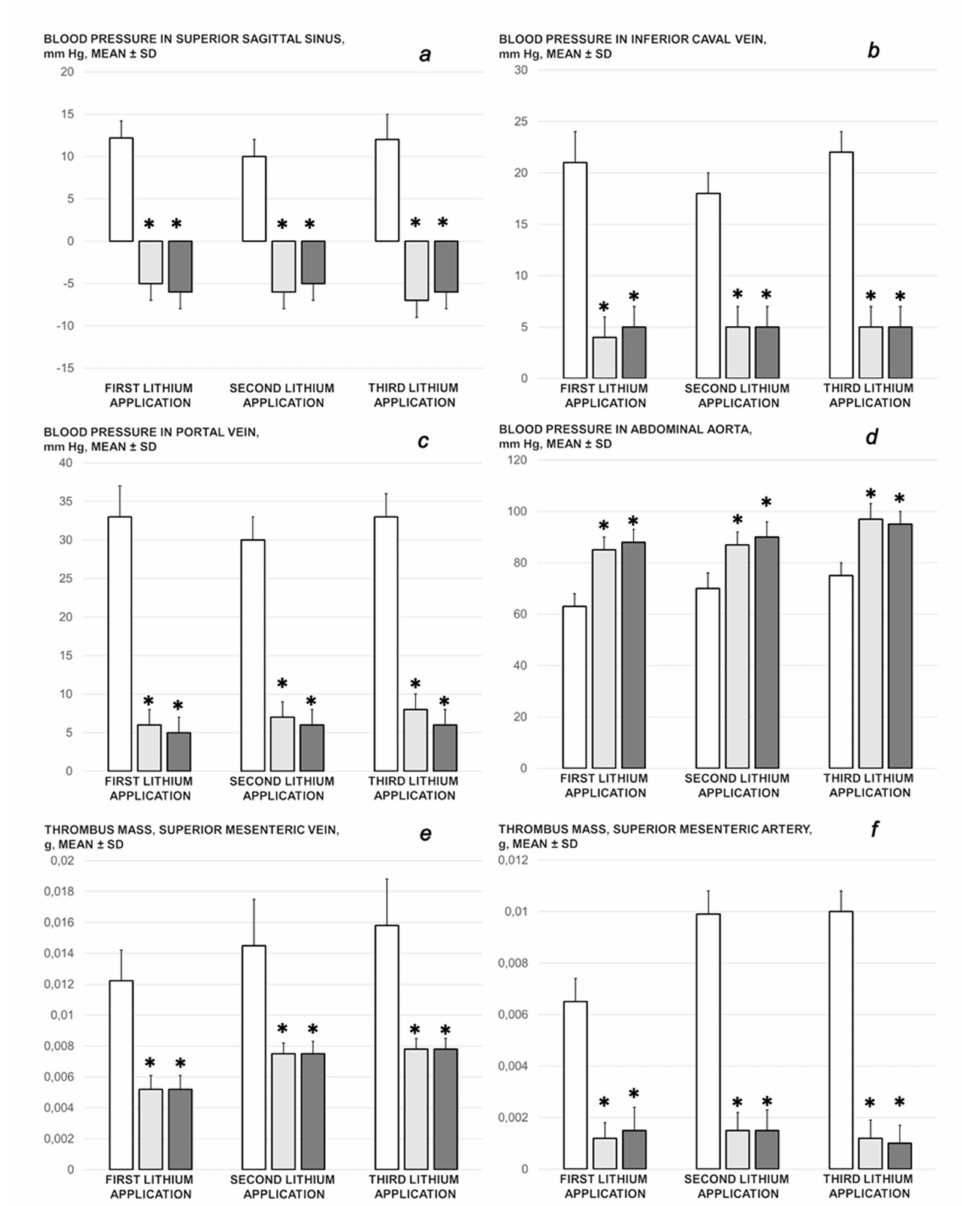
Figure 1. Blood pressure in the superior sagittal sinus ( a ), inferior caval vein ( b ), portal vein ( c ), and abdominal aorta ( d ), and thrombus presentation in the superior mesenteric vein ( e ) and superior mesenteric artery ( f ) in the lithium-treated rats after the first, second, and third lithium sulphate administration (500 mg/kg/day intraperitoneally for 3 consecutive days). BPC 157 10 µ g/kg (light gray bars), 10 ng/kg (dark gray bars); saline 5 mL/kg (white bars) given intraperitoneally after each of the lithium administrations. Six rats/group/interval. Means ± SD, * p < 0.05, at least, vs.